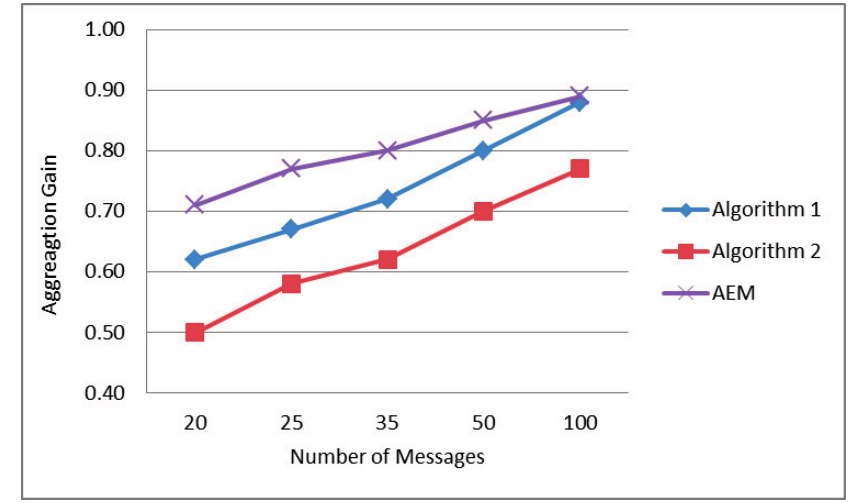
Figure 8. Total aggregation gain as a function of network